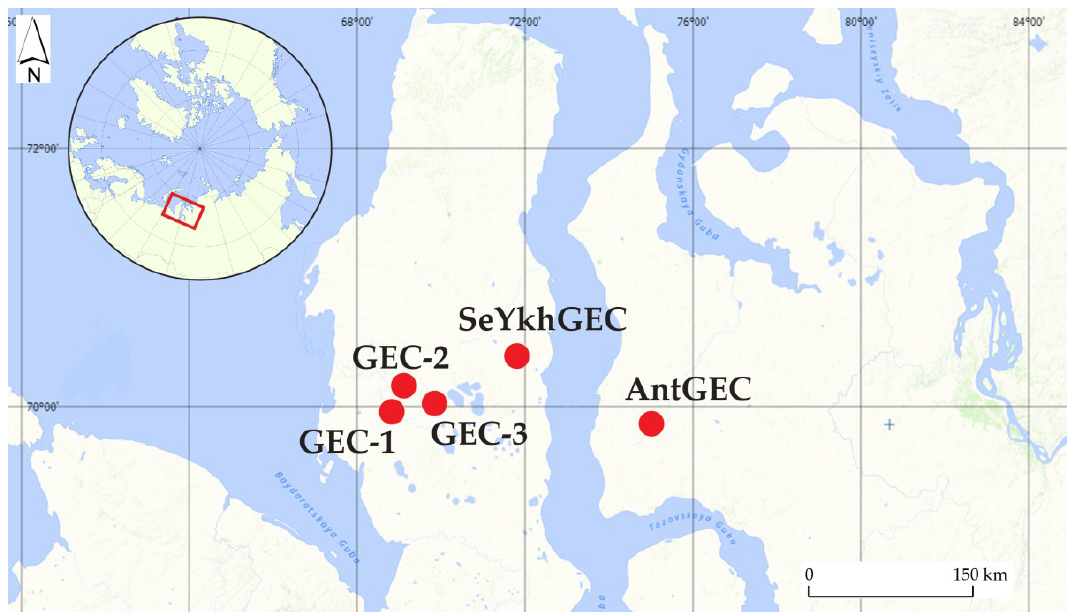
Figure 1. Location of gas-emission craters (GECs), at which field observations were undertaken. Table 1. Coordinates (WGS84) of gas emission craters presented in the paper.